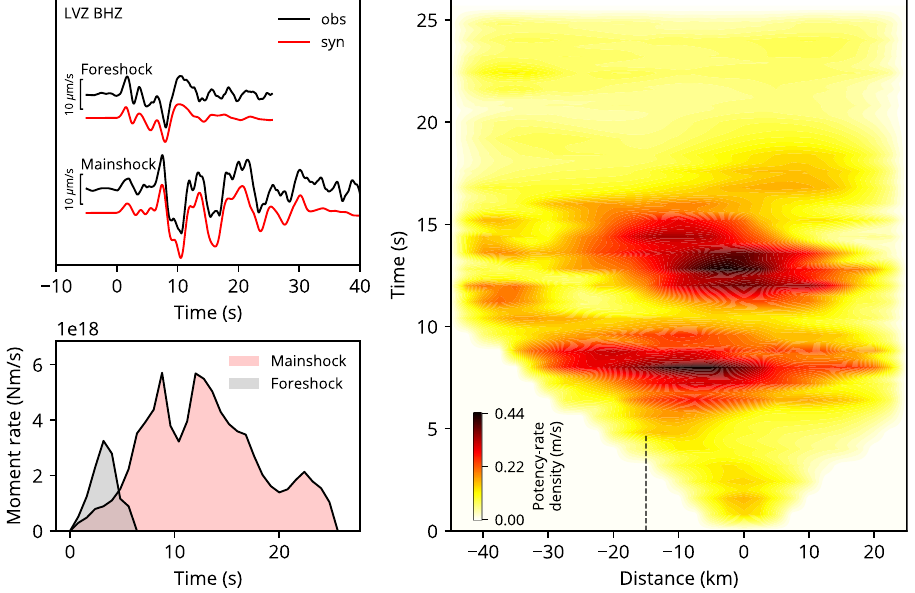
Figure 2. The left-top panel shows waveform fitting for the largest foreshock and the mainshock at the selected station (LVZ). The left-bottom panel shows the moment-rate functions. The right panel shows potency-rate density evolution projected along-strike (200° azimuth) distance from the mainshock epicentre. The black dashed line indicates the location where the rupture apparently stagnates, approximately 15 km north-northeast of the mainshock